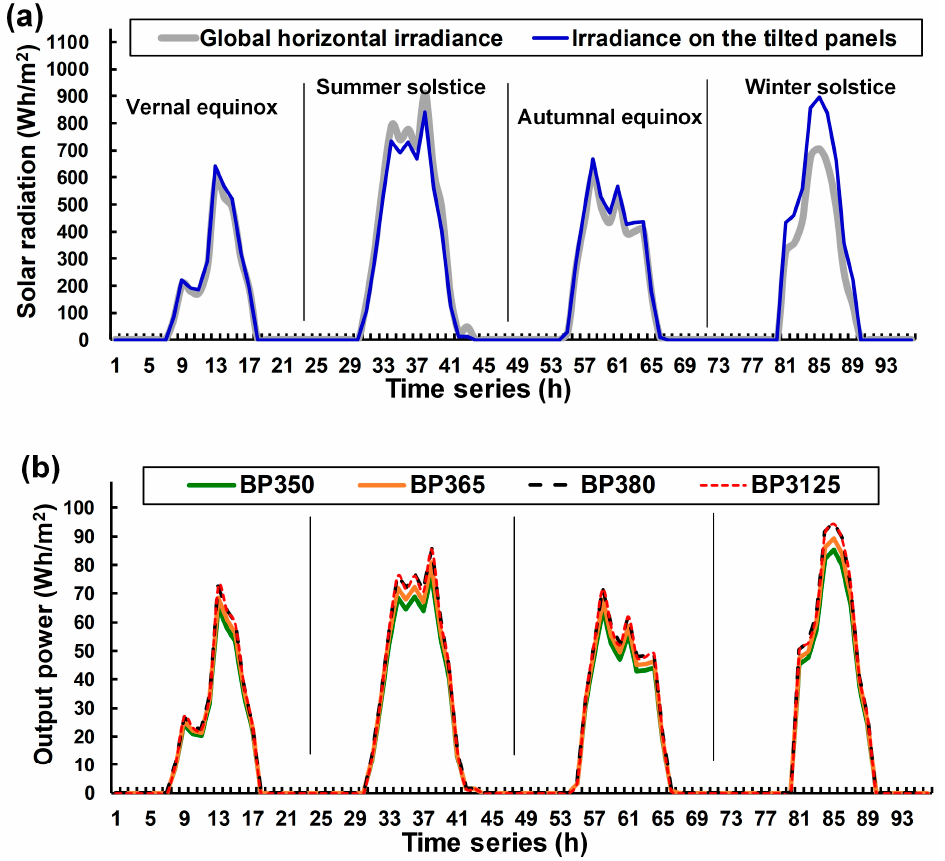
Figure 3. Spring and autumn equinoxes and summer and winter solstices in 2016: ( a ) Hourly solar radiation; ( b ) Estimated hourly output power of BP3 series modules.